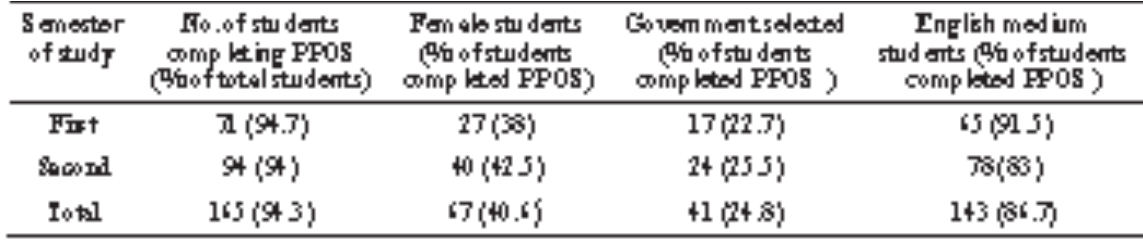
Table I : Distribution of respondents according to semester of study, sex, procedure of selection and me- dium of school